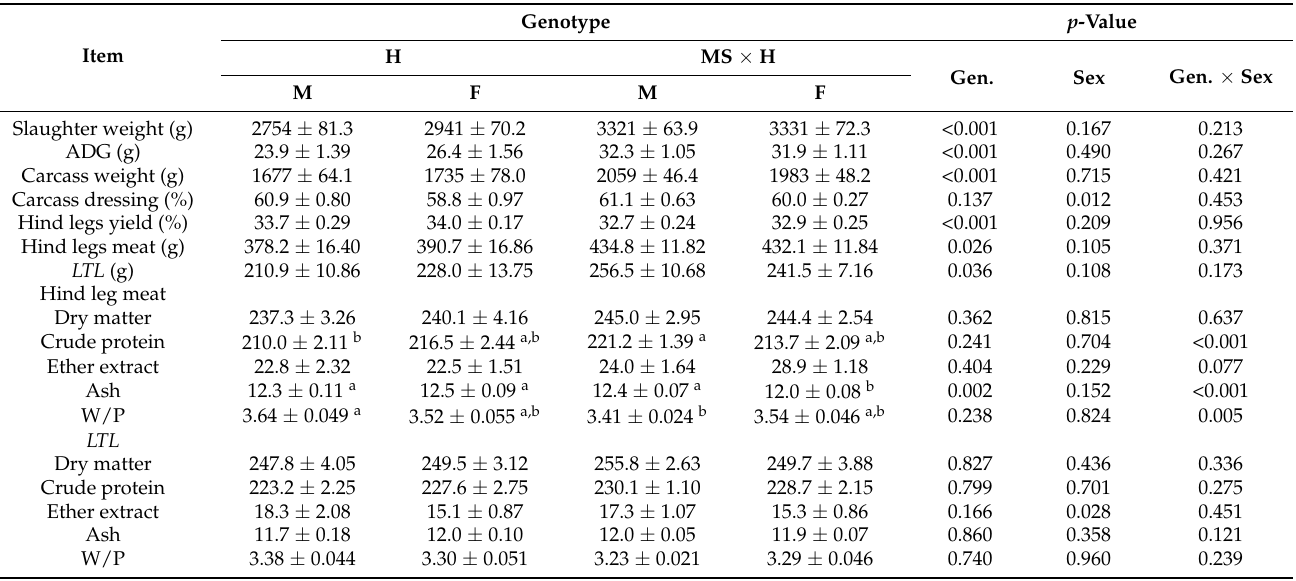
Table 3. Carcass traits and proximate chemical composition (g/kg of fresh meat) of rabbit meats in relation to the genotype and sex.